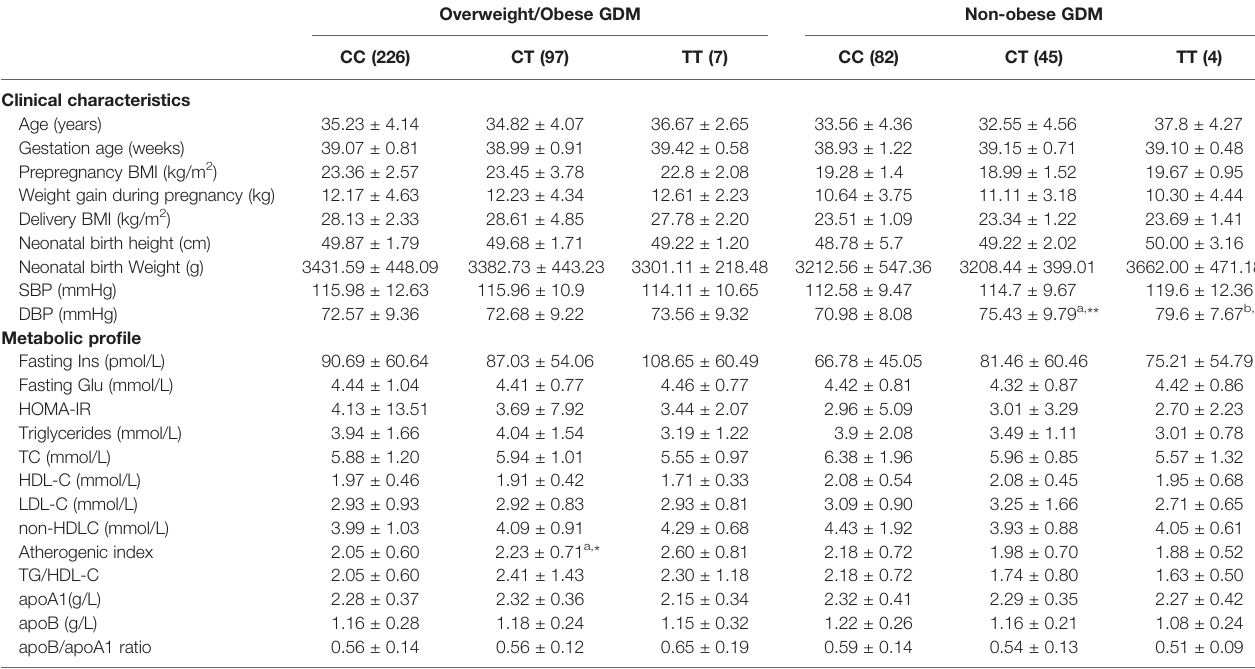
TABLE 6 | Clinical characteristics and metabolic pro fi le of GALNT2 rs2144300 genotypes in overweight/obese and non-obese GDM patients. Overweight/Obese